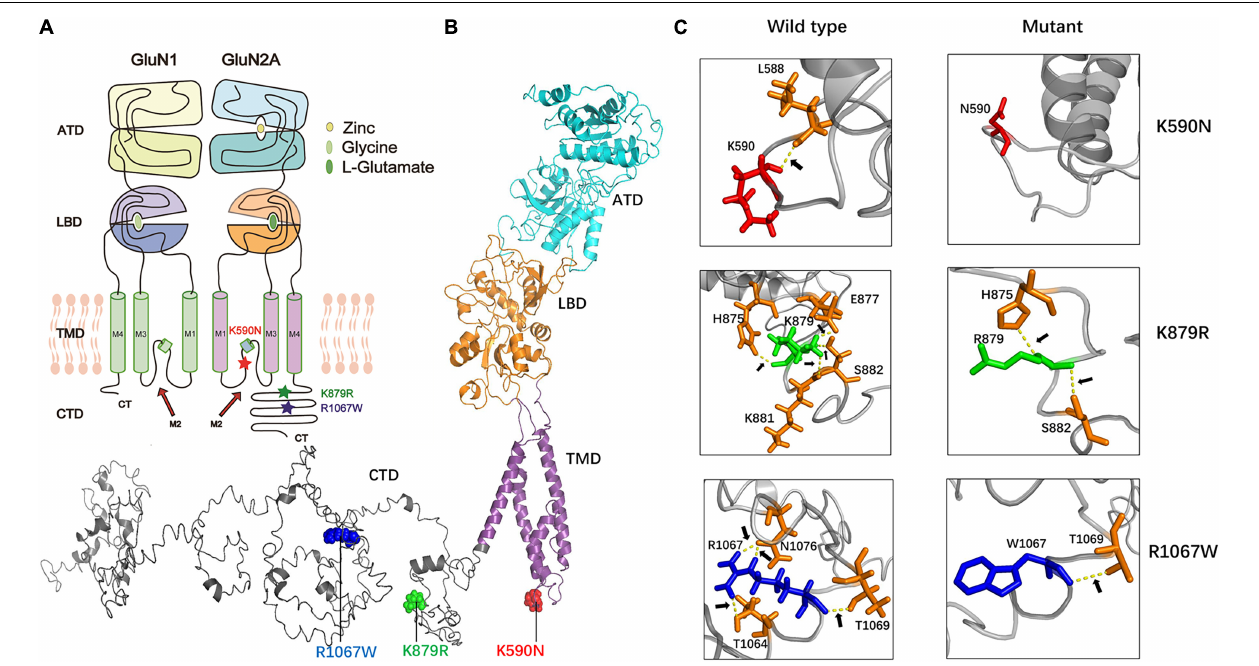
FIGURE 2 | The alterations of hydrogen bonds with surrounding amino acids. (A) The locations of missense mutations in topological structure of GluN1/GluN2A. Residue K590N in GluN2A lies within the channel pore of the NMDAR, while residues K879R and R1067W lie in carboxyl-terminal domain. Mutation K590N was colored in red, mutation K876R was colored in green, and mutation R1067W was colored in blue. (B) Schematic illustration of the location of mutations in the three-dimensional structure of GluN2A. (C) Alterations of hydrogen bonds with surrounding amino acids. In wild type, residue K590 forms one hydrogen bond with L588. In the mutant, this hydrogen bond was destroyed. In wild type, residue K879 forms hydrogen bonds with H875, E877, K881, and S882 while in the mutant, the hydrogen bonds with E877 and K881 were destroyed. In wild type, residue R1067 forms hydrogen bonds with T1064, T1069, and N1076 while in the mutant, only hydrogen bond with T1069 was